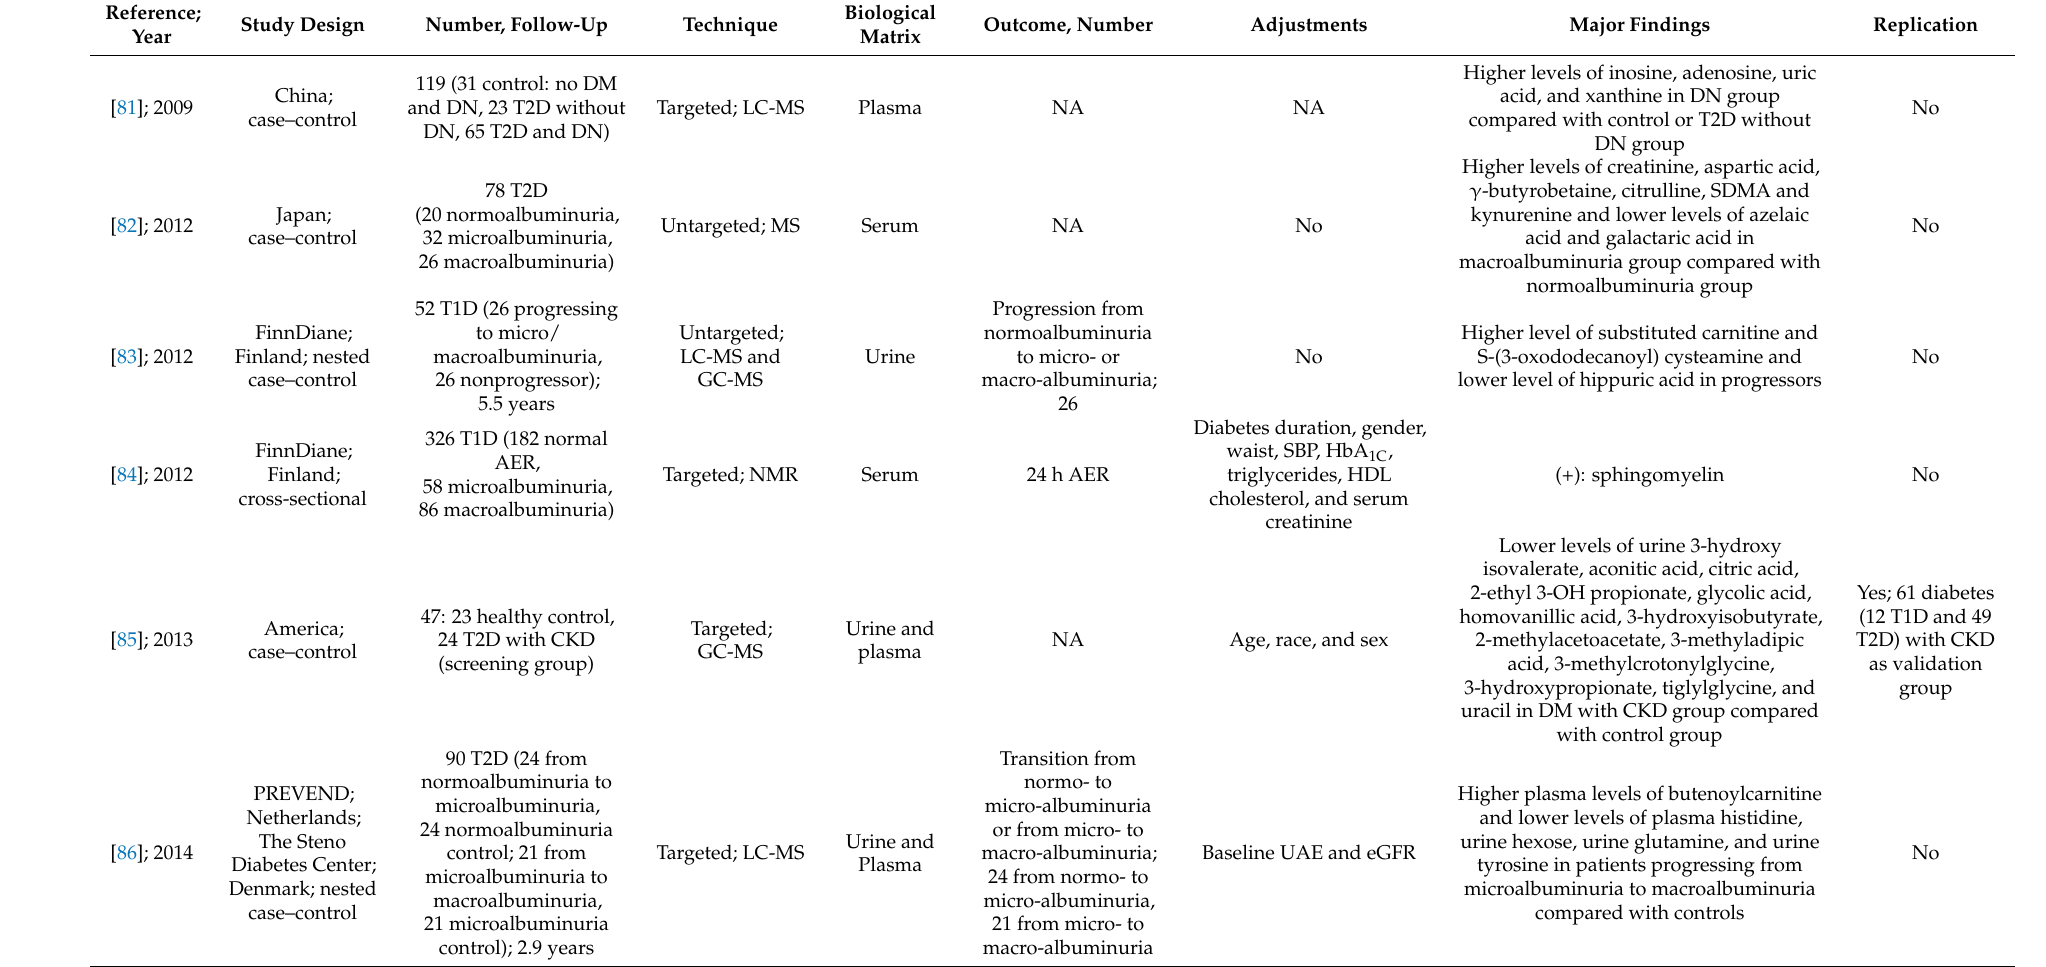
Table 3. Circulating metabolites associated with diabetic kidney disease in human